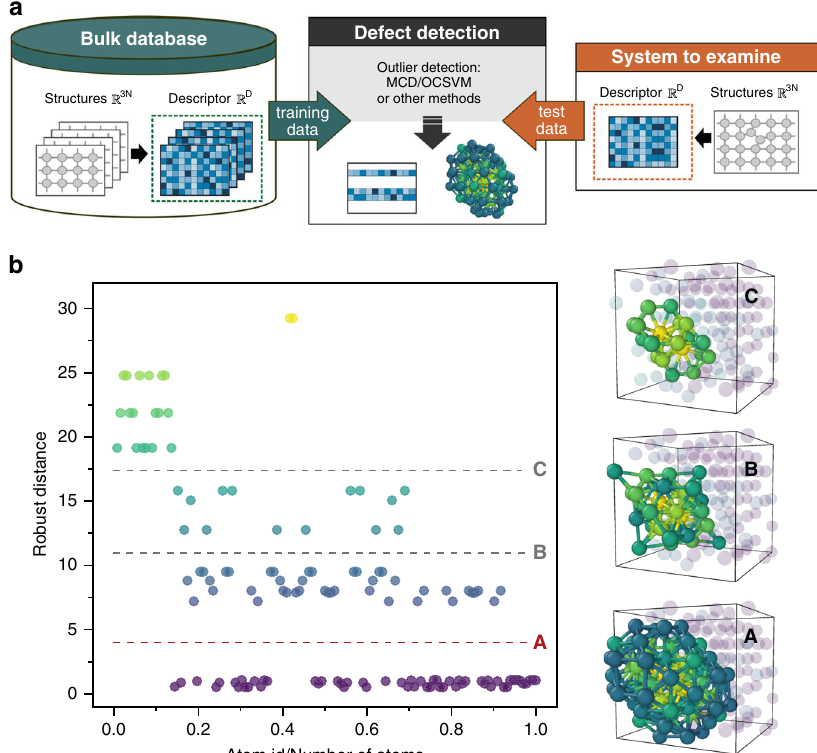
Fig. 1 Defect detection and strati fi cation based on the distortion score. a Scheme of the defect detection. The training data set consists of the defect-free bulk structures. The structures for the training and test are represented in the same feature space R D of atomic descriptors. To perform defect detection, each atomic environment from the test system is compared to the learned bulk structures and characterized by distortion score. Atoms with scores above the critical threshold are classi fi ed as structural outliers that form the defect. b Detection and strati fi cation of four self-interstitials cluster with C15 — based on the distortion score provided by robust MCD. Each point on the plot represents an atom in the simulation box. The colour of morphology 38 — I C15 4 points corresponds to the colour of atoms in the inset structures. The threshold between the bulk (atoms-inliers) and defect (atoms-outliers) is indicated with a dashed red line, labelled as A. The grey dashed lines B and C indicate the possibilities for defect strati fi cation. The defect structures A, B, C are obtained using the corresponding